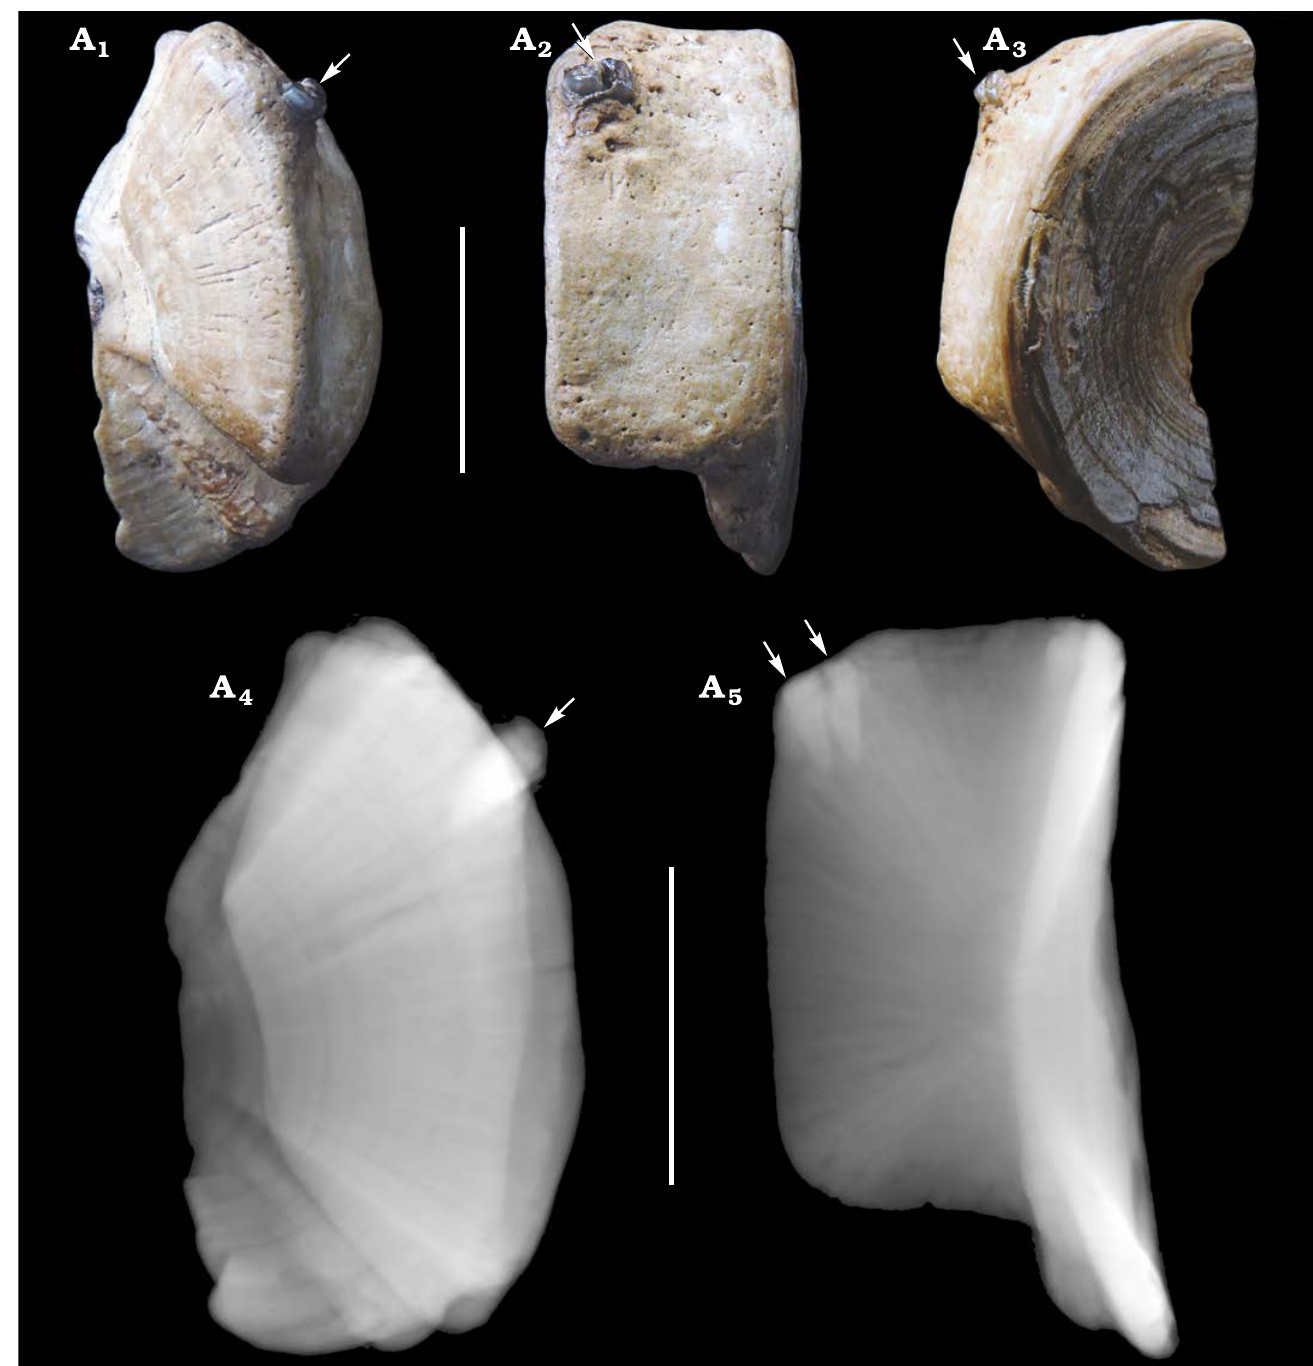
Fig. 1. Centrum of Carcharhinidae indet. (CMM-V-2700) from the Miocene Calvert Formation in Chesapeake Beach, MD, USA. Centrum in articular cross-sectional (A 1 ), lateral (A 2 ), and articular (A 3 ) views; CT-scan in articular view (A 4 ); CT-scan in lateral view (A 5 ). Arrows indicate the two shark teeth embedded in and protruding from the upper quadrant of the centrum. Scale bars 10